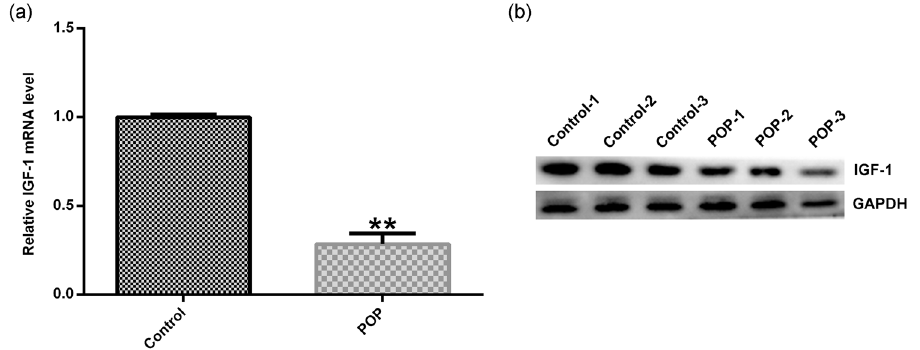
Figure 1: The expression of IGF - 1 in the vaginal wall tissues of POP. Vaginal wall tissues were obtained from 30 patients having POP or other diseases that required hysterectomy and qRT - PCR ( a ) and Western blotting ( b ) were used to detect IGF - 1 mRNA and protein expression. Data were reported as mean ± SD. ** p < 0.01 vs control group.